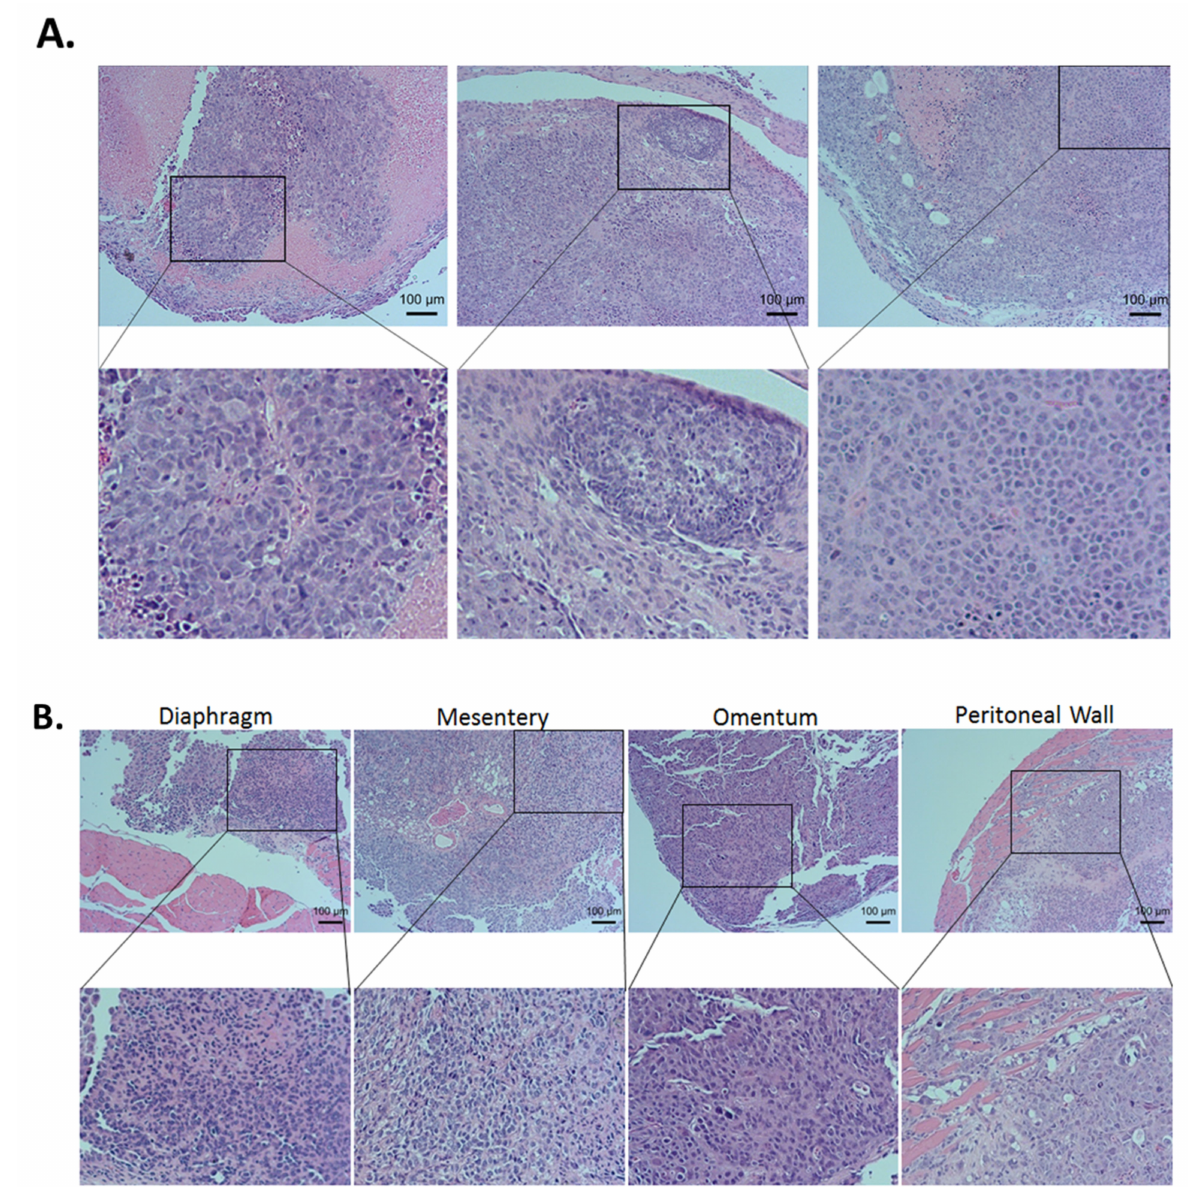
Figure 7. Representative H&E staining of the tumor sections from the ovaries ( A ) and representative H&E staining of the tumor sections from other organs ( B